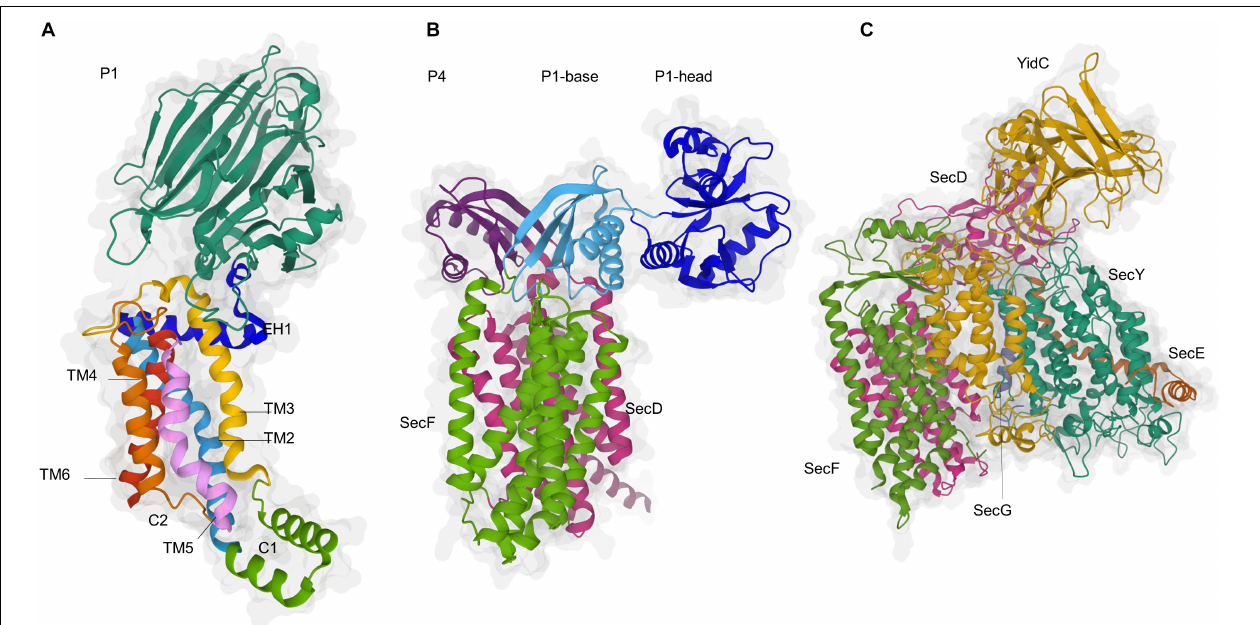
FIGURE 10 | Structures of YidC, SecDF and a model of the holo-translocon. (A) Structure of YidC from E. coli (PDB 6AL2). The conserved transmembrane domains (TMs) 2 to 6 of YidC are indicated (TM2, light blue; TM3, yellow; TM4, orange; TM5, light pink; TM6, red), while the structure of TM1 is still unknown. The short amphipathic helix EH1 is depicted in dark blue, the periplasmic loop P1 in dark green and the cytoplasmic loop C1 in light green. (B) Structure of the SecDF complex from Thermus thermophilus (PDB 5YHF). SecDF consists of 12 TMs, six each in SecD (TM1-6, pink) and SecF (TM7-12, green), and three periplasmic domains, termed P1-head (dark blue), P1-base (light blue) and P4 (yellow). (C) Modell of the holo-translocon based on the cryo-EM structure from E. coli (PDB 5MG3). SecY is shown in green, SecE in orange and SecG in blue, its ancillary subunits SecD in pink, SecF in green and YidC in